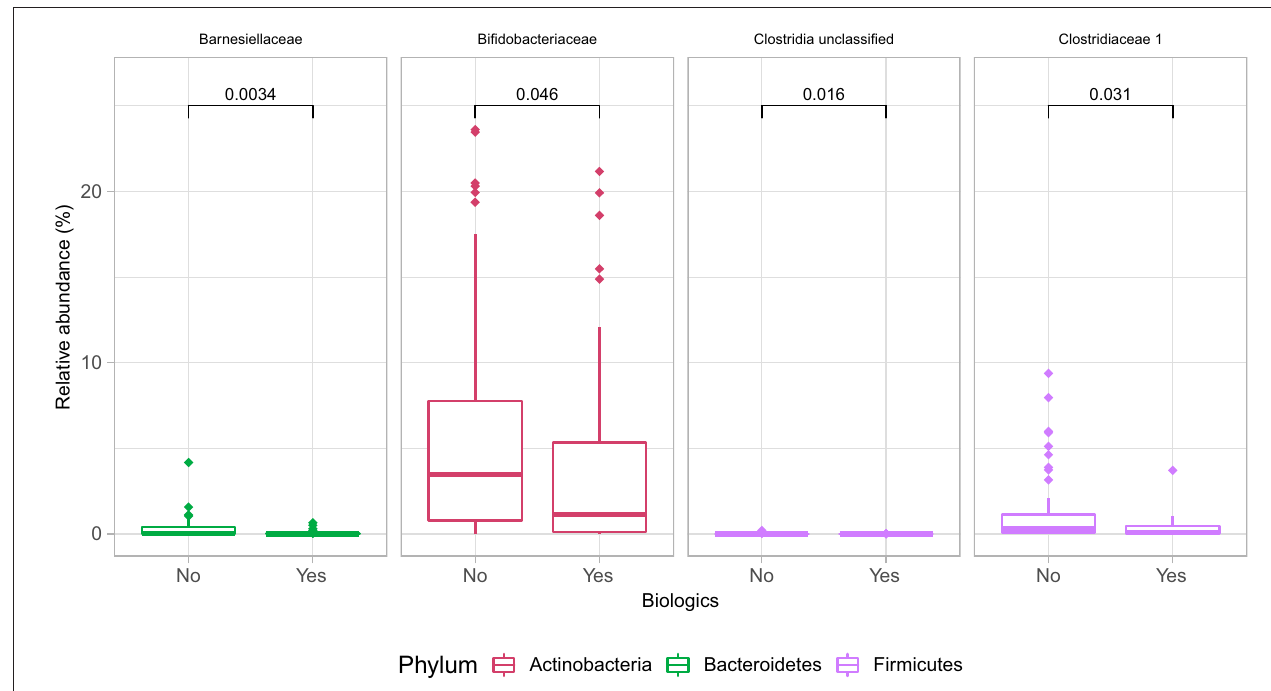
FIGURE 7 | Differences in some microbial family abundances between the two treatment options in CD group (biologics vs. non-biologic). Only significantly different families are shown (Wilcoxon, p ≤ 0.05).